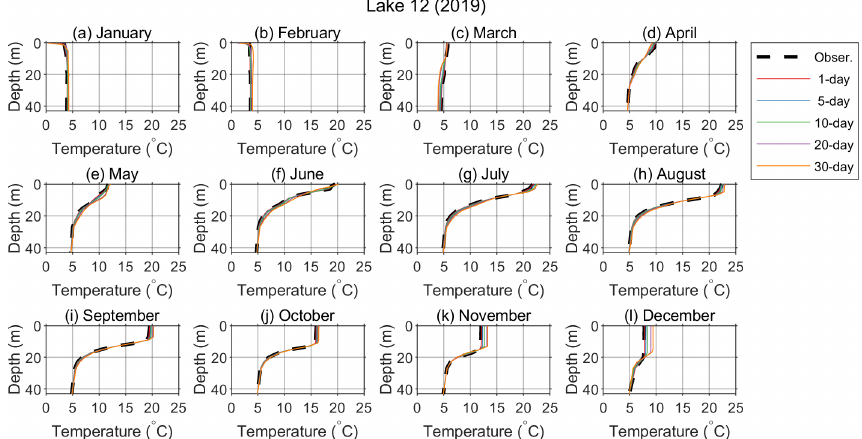
Figure 11. Annual variation in the vertical profile of the water temperature. Panels (a) to (l) show the monthly means of the observed and predicted values in Lake 12 for